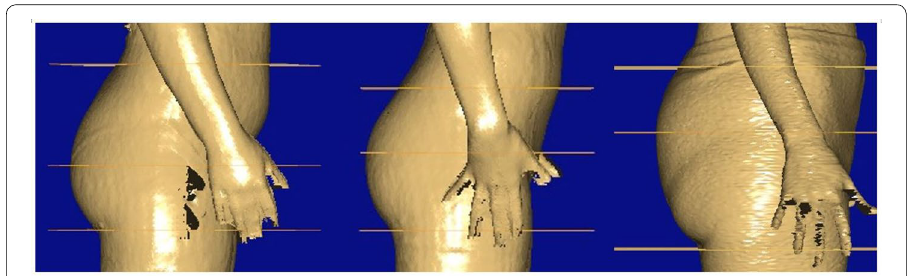
Fig. 12 Examples of buttocks fullest part location, from left: low, middle, and